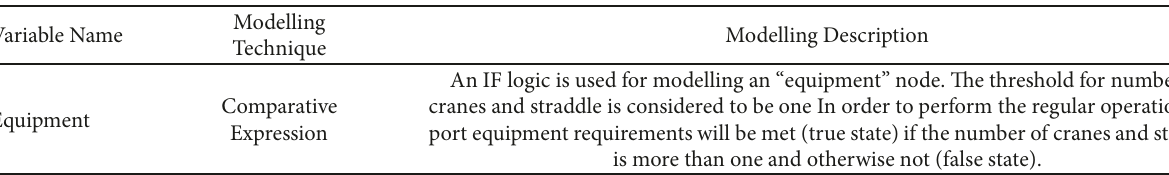
Table 4: Modelling of equipment